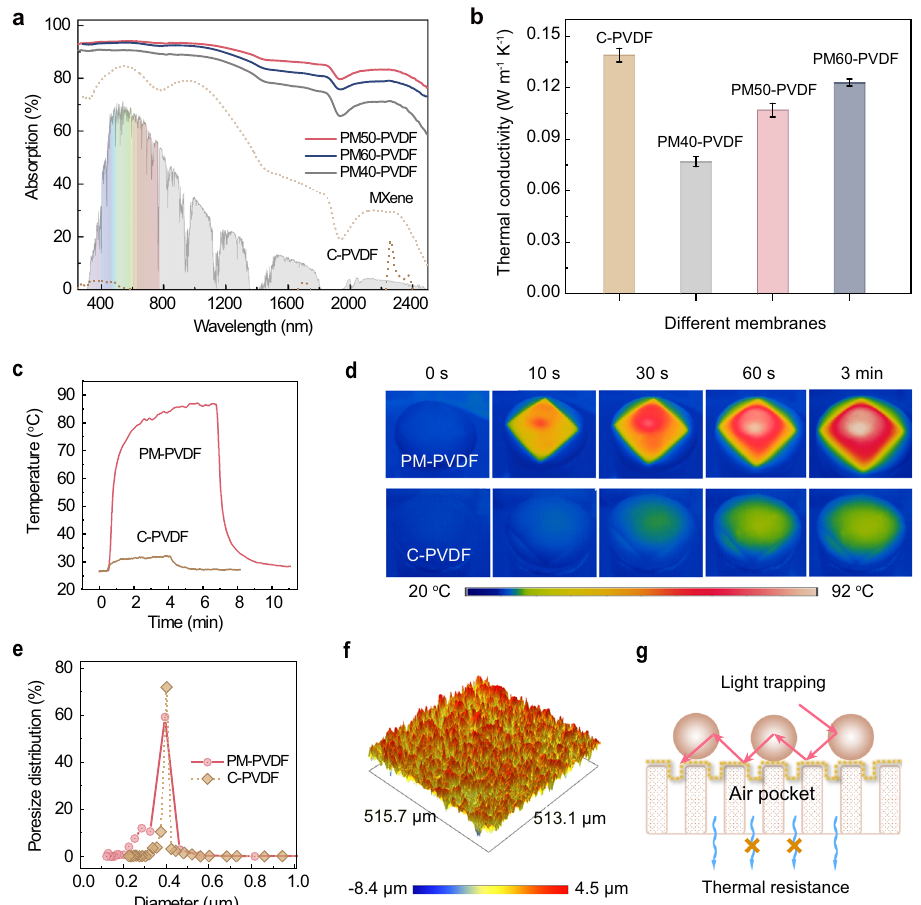
Fig. 3 Photothermal effect and thermal conductivity of membranes. a UV-vis-NIR absorption spectra of the membranes. b The corresponding thermal conductivities. Error bars indicate the standard deviations estimated from three times measurements. c Surface temperature pro fi les as a function of time and ( d ) the corresponding IR thermal images. e Pore sizes distribution. f Typical optical surface pro fi le of the PM-PVDF. g Schematic illustration of the PM- PVDF with favorable light trapping and thermal resistance. The hierarchical topology maximizes the sunlight harvesting by the light trapping effect, and meanwhile, the trapped air pockets in the membrane serve as thermal resistance to alleviate thermal conduction through the membrane and achieve ef fi cient solar utilization. Source data are provided as a Source Data fi